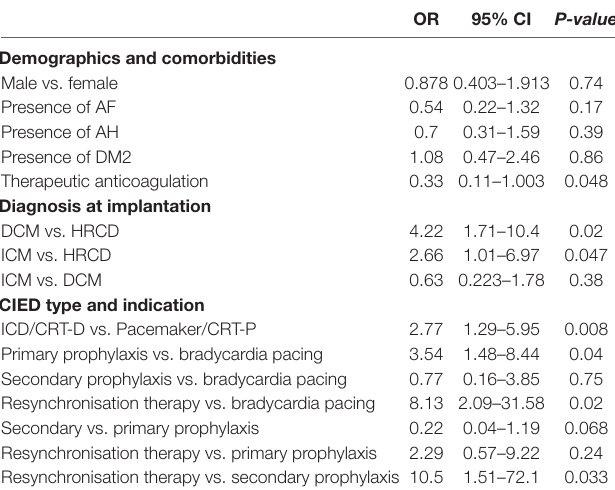
TABLE 3 | Calculated odd risks for incidental non-infectious CIED lead